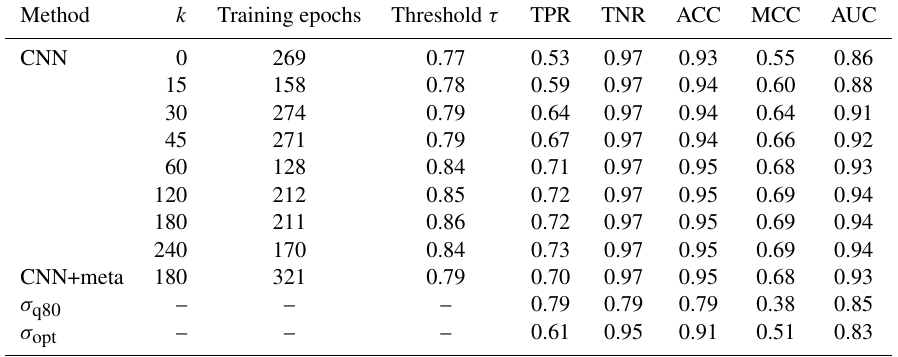
Table B1. Number of training epochs, MCC optimized threshold, and resulting metrics for different values of k evaluated on